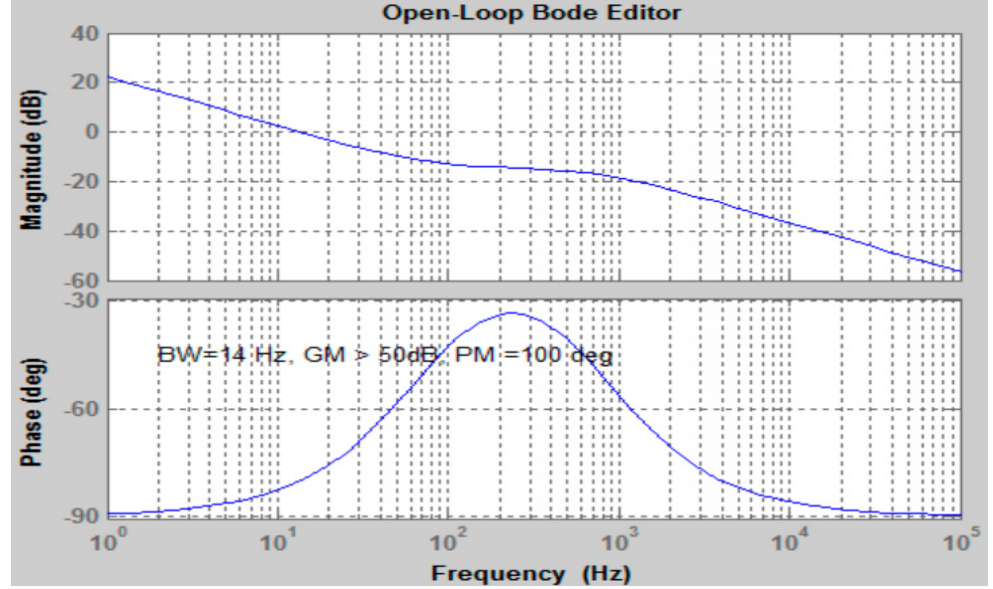
Figure 7. Frequency domain response of the voltage open-loop transfer function of the fly-back Figure7. converter.